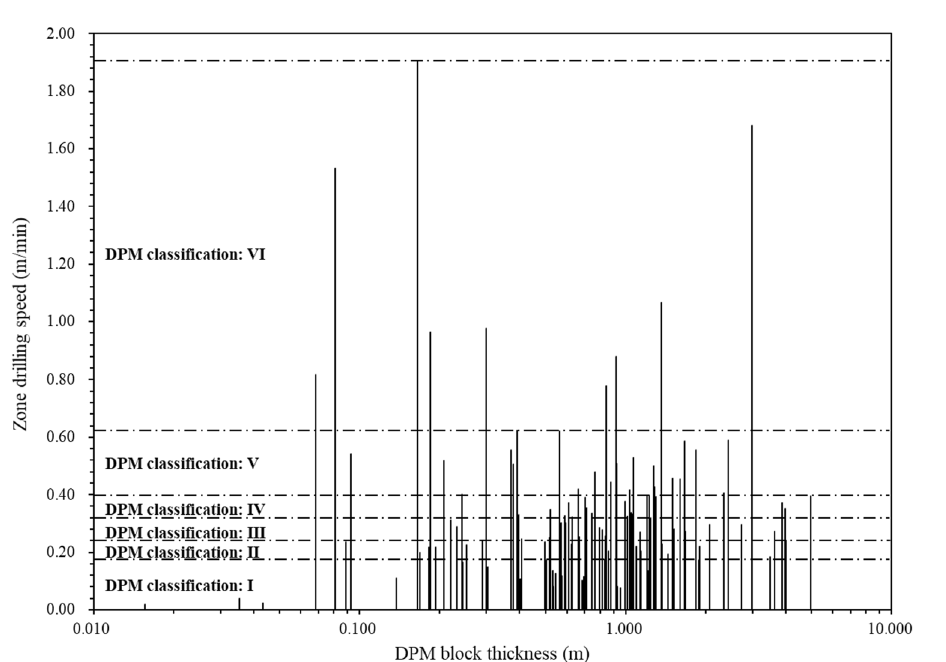
Figure 16. Distributions of drilling speed with its linear zone